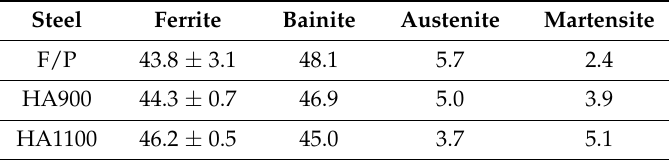
Table 4. Phase volume fractions for each steel [%].